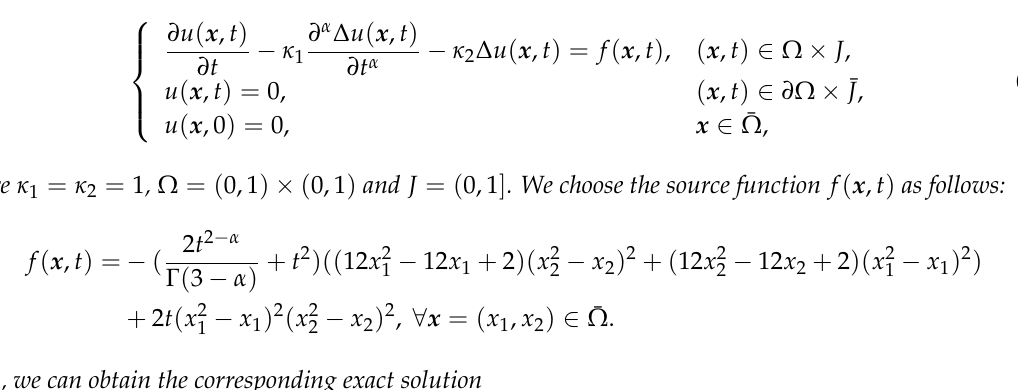
(cid:107) with h = h